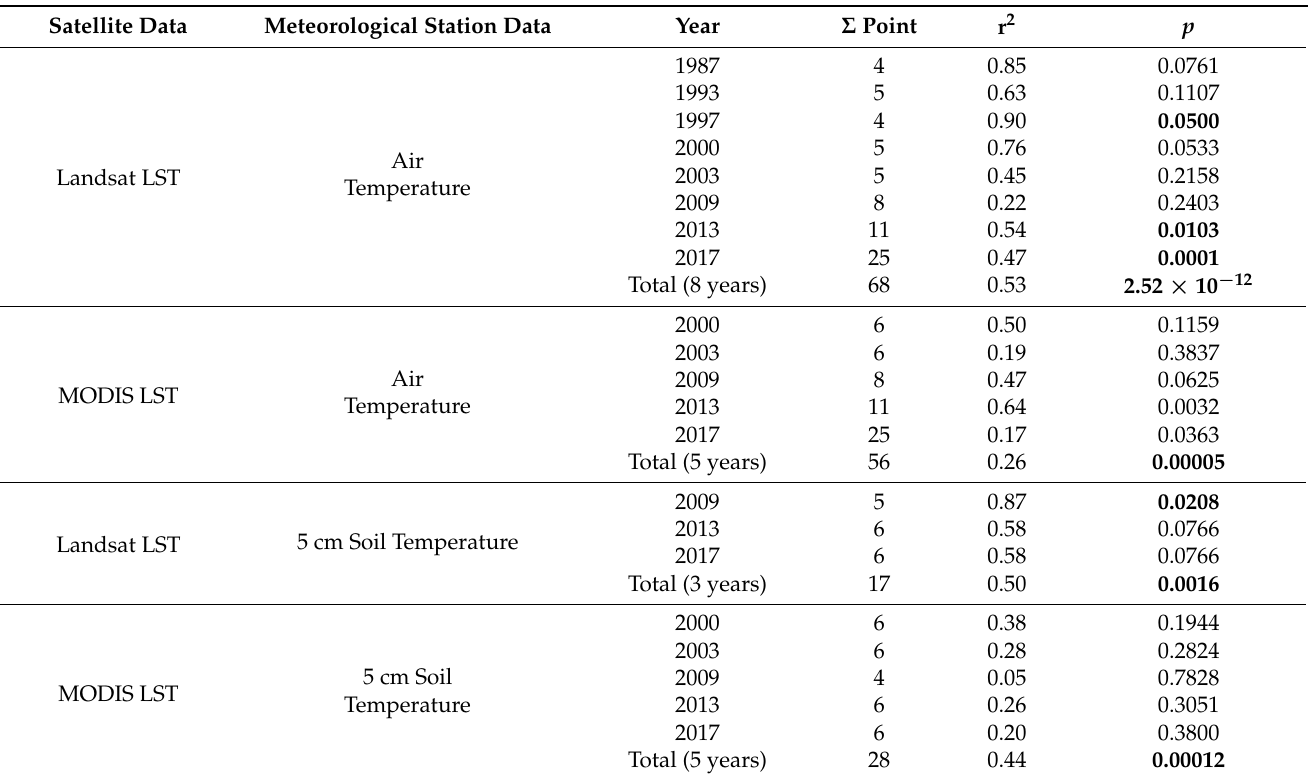
Table 4. The correlations and p